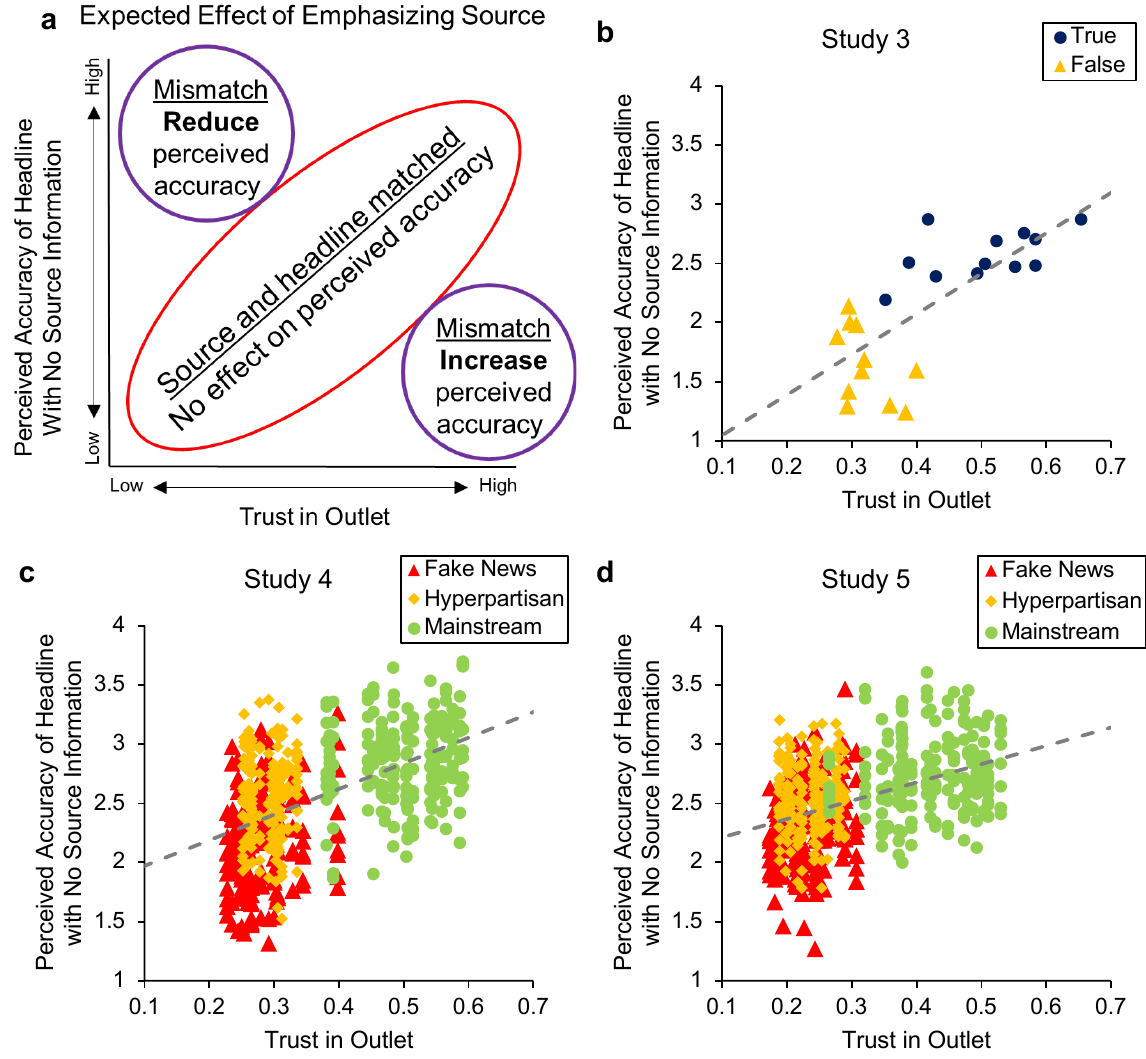
Figure 3. Relationship between trust in outlet and headline plausibility. Diagram of expected impact of emphasizing source given (mis)match outlet trust and headline plausibility when no information was provided (a) and data from Studies 3 (b), 4 (c), and 5(d). Each data point represents one headline. In panels b-d, 0 corresponds to the minimum value of the trust scale and 1 corresponds to the maximum